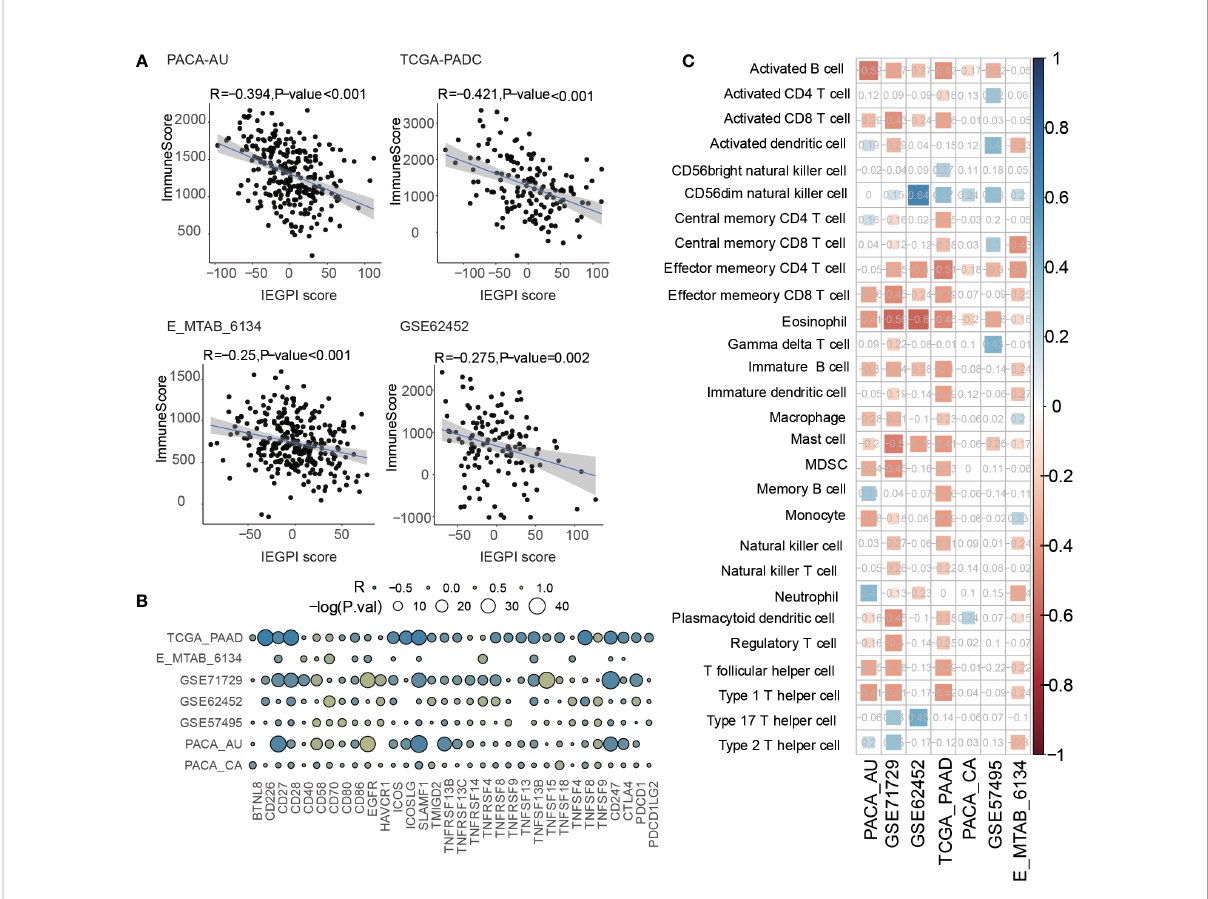
FIGURE 5 Relationship between the immune in fi ltration and IEGPI score. (A) Relationship between the IEGPI score and immune score in four public datasets; (B) correlation of the IEGPI score with immune co-stimulation and check-point genes in seven datasets; (C) Relationship between the expressions of 28 immune cells and IEGPI score in seven